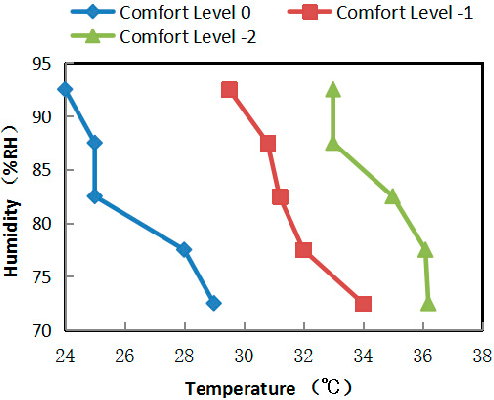
Figure 6. The temperature and humidity boundary curves under different comfort conditions.